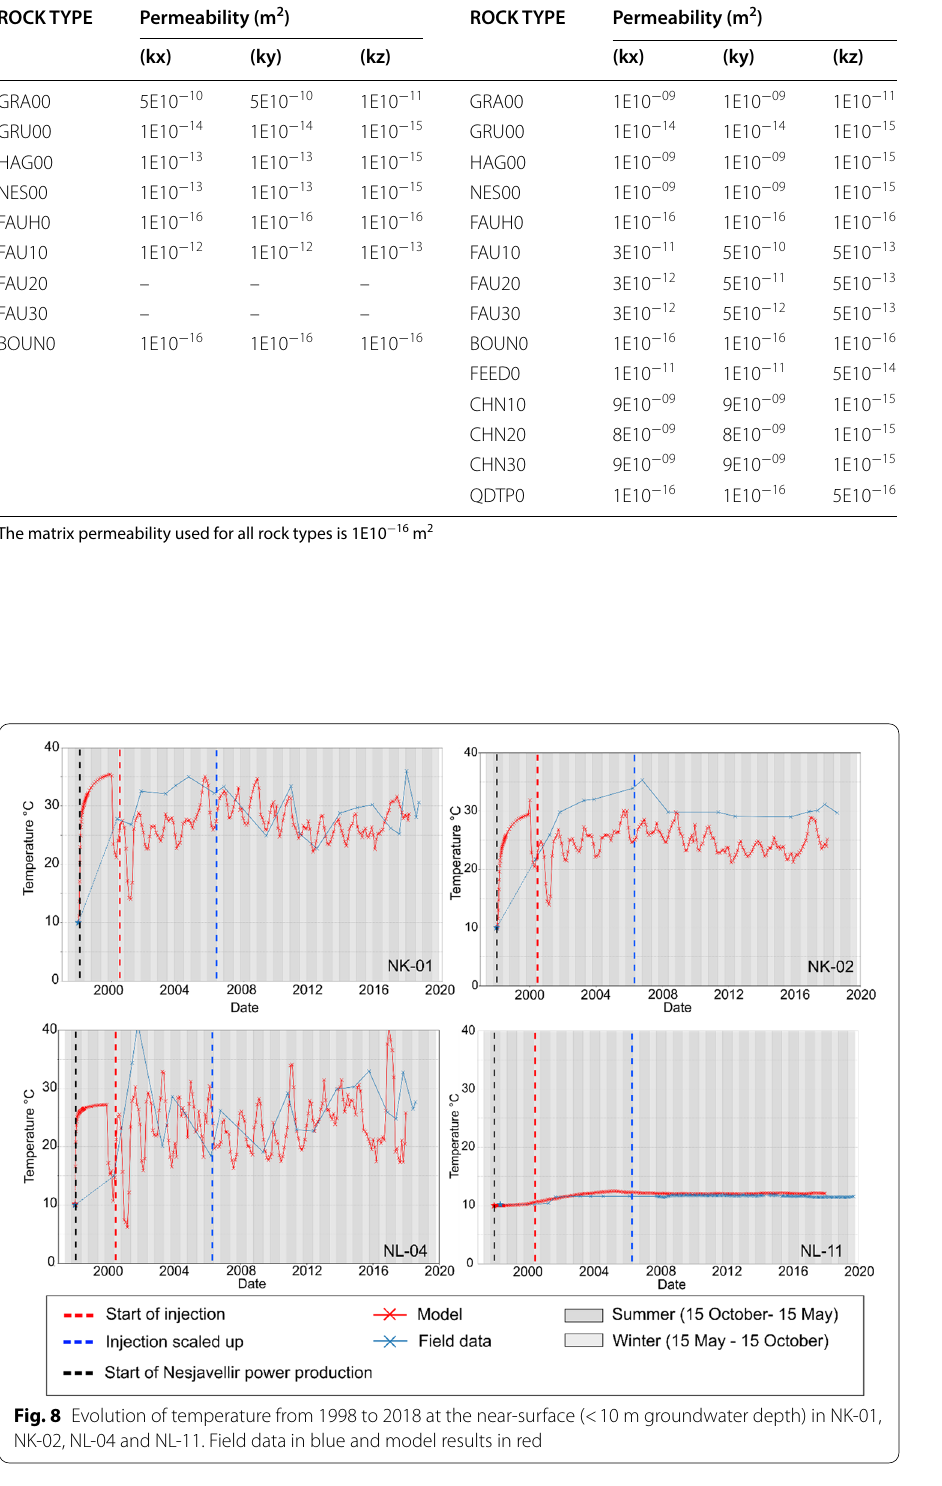
Table 2 Initial fracture permeability values and rock types based on previous studies (Bodvarsson et al. 1990; Zakharova and Spichak 2012; Snæbjörnsdóttir et al. 2014) and geologic model, and calibrated permeability values with additional rock types illustrated in Fig. 7